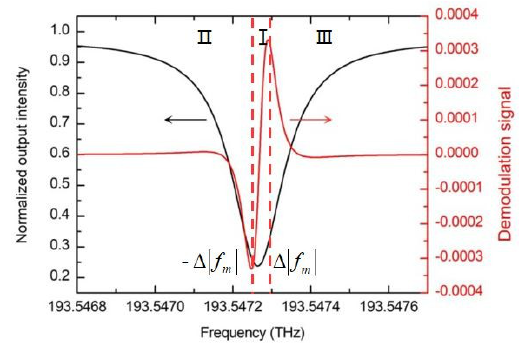
Figure 2. Schematic diagrams of the resonance curve and the demodulation curve. In this picture, the perimeter of the WRR is set to be 10.05 cm and the propagation loss is set to be 0.15. The coupling coefficient is 0.12 and the insertion loss of the coupler is 0.02 dB. The modulation frequency of the sinusoidal wave modulated signal is 2 MHz. The gain coefficient of the demodulation circuit is 0.7, and the photoelectric conversion efficiency is 1000. To achieve high carrier suppression, J 0 ( M ) = 0, the modulation index M is 2.405.